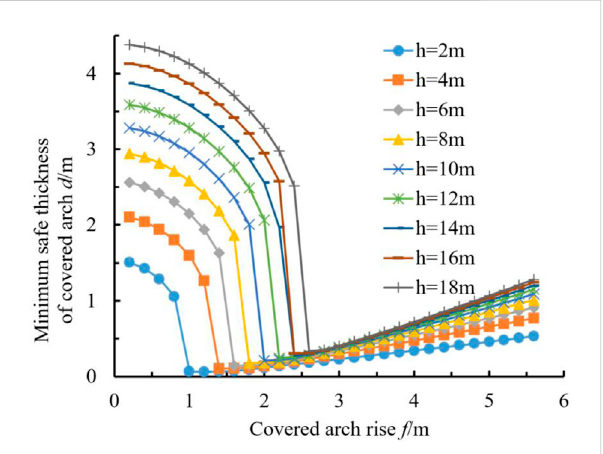
FIGURE 7 Relationship between thickness and covered arch rise with different tunnel depth (case 1)